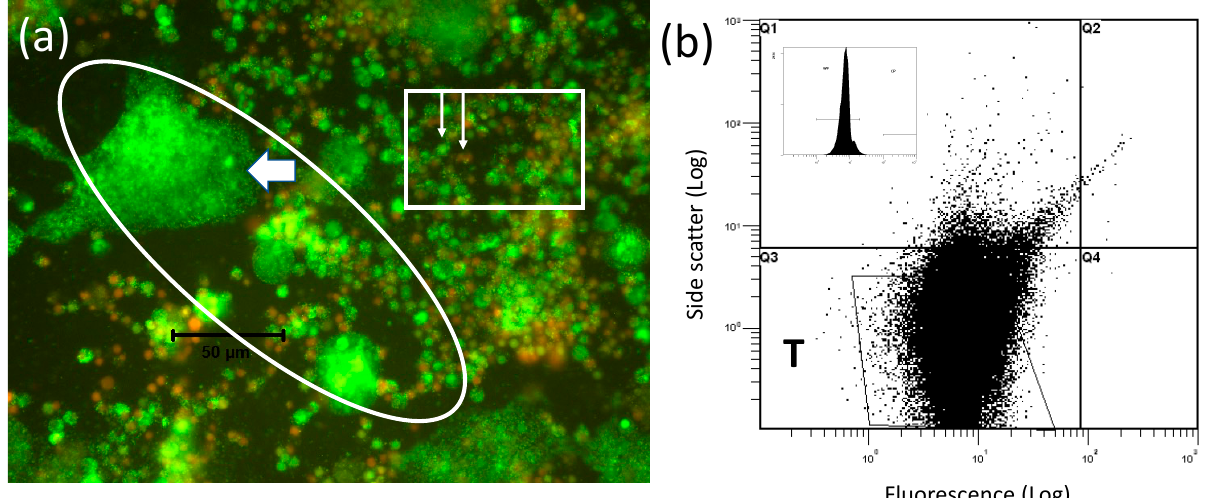
Figure 4. w AlbB harvested from C7-10 cells treated with mitomycin C. Panel ( a ) shows an image of cells represented in Figure 3d after a two-week incubation with mitomycin C-treated feeder cells. Based on size (approximately 10-micron diameter) and appearance of nuclei, cells shown in the rectangle are Aa23 cells introduced as the inoculum. White arrows show nuclei of live (green) and dead (red) Aa23 cells. The oval region shows the aberrant morphology and high levels of Wolbachia (barely visible, small green dots such as those in the syncytium-like structure to the left of a white, leftward pointing arrow) that develop in the feeder layer. The black size marker that crosses the oval at left indicates 50 microns. Panel ( b ) shows the final w AlbB scatter plot after purification by filtration and centrifugation as described previously for C/ w Stri1 cells [103]. The inset shows the WP